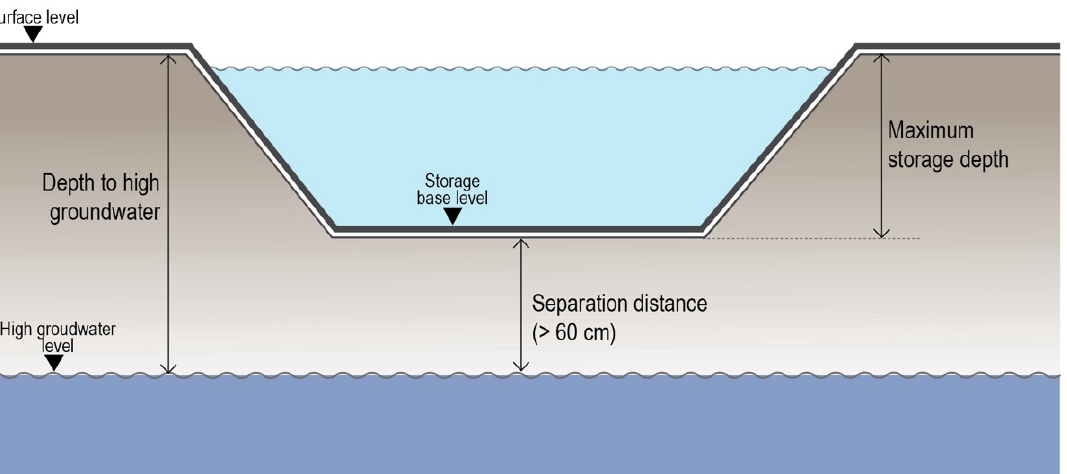
Figure 3. Maximum storage depth is defined as the depth to a high groundwater level minus a separation distance between high groundwater and the storage base level. A minimum separation distance of greater than 60 cm is commonly recommended.